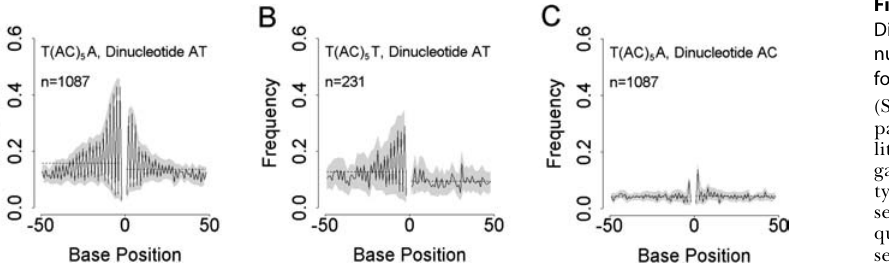
Figure 4. Flanking Sequence Frequency Distributions for Three Representative Di- nucleotide Motif–Cassette Combinations for (AC) 5